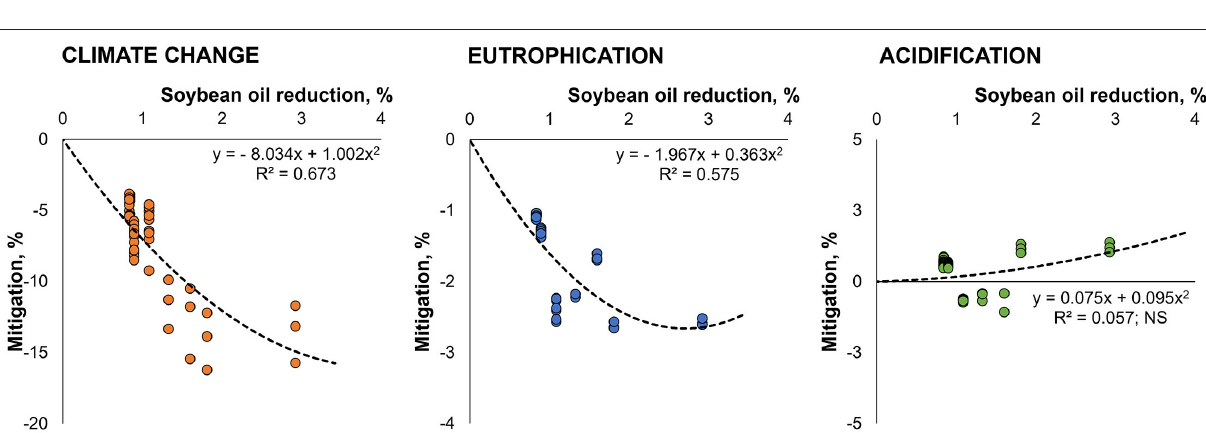
FIGURE 4 | Potential environmental impact mitigation associated with the production of broiler feeds, considering energy savings from an energy matrix of 45 kcal of ME/kg of feed released by β -mannanase supplementation in different grain production scenarios; SO-SO, Soybean and corn produced in Southern Brazil; CW-SO, Soybean produced in Central-West Brazil and corn produced in Southern Brazil; CW-CW, Soybean and corn produced in Central-West Brazil.